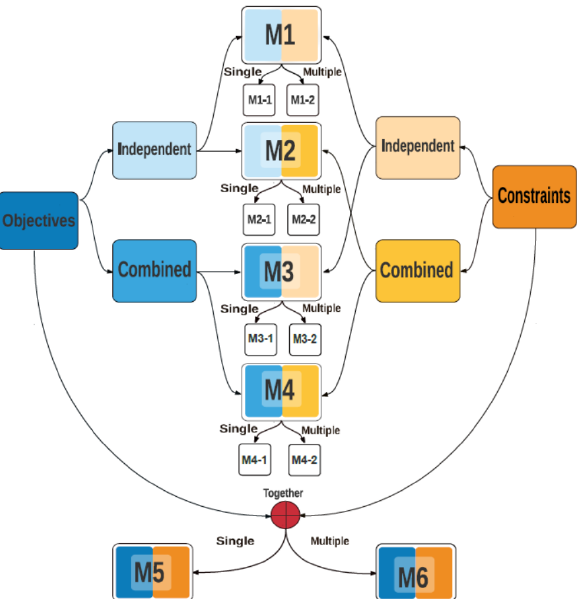
Figure 1. The proposed taxonomy of 10 different metamodeling frameworks for multi- and many- objective optimization. (Taken from